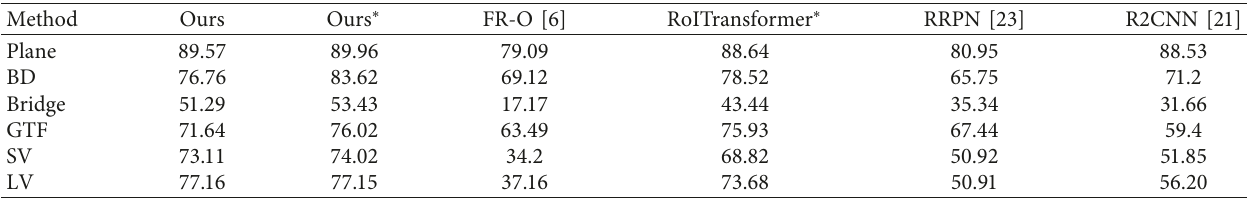
Table 3: The results on the DOTA test set indicating that the verification set is also used for training; otherwise, only the training set is used for training.